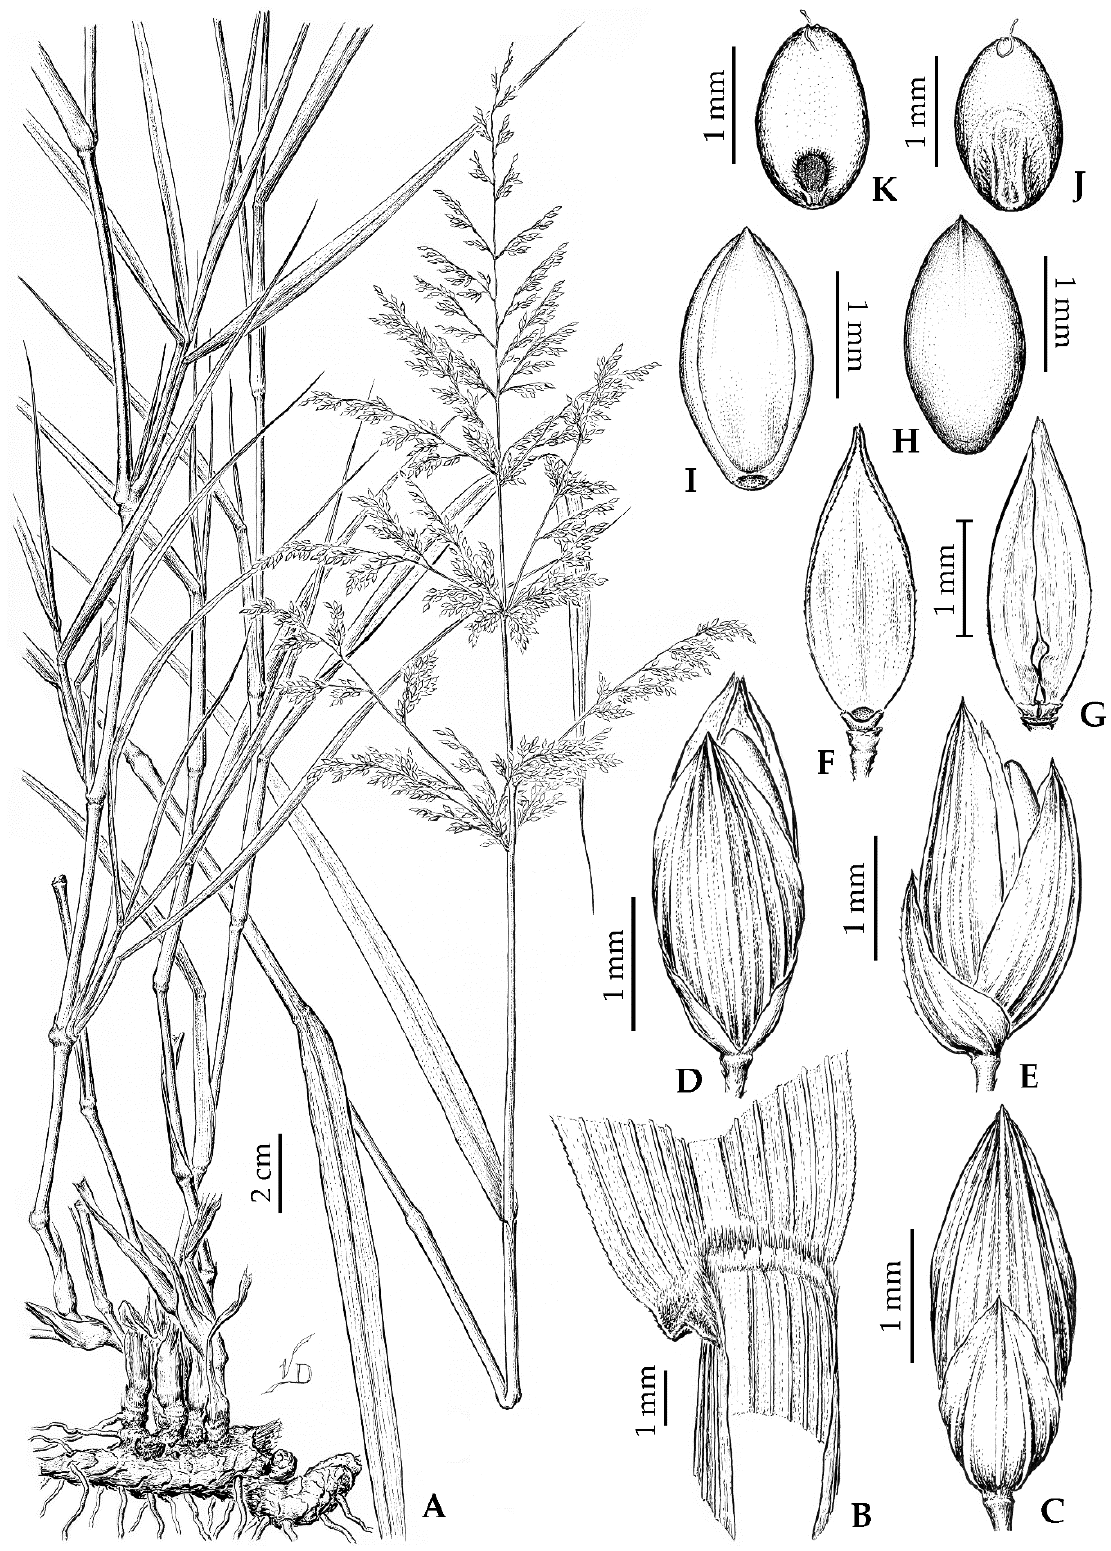
Figure 2. Janochloa antidotale (Retz.) Zuloaga & Delfini: ( A ). Plant; ( B ). Ligular region; ( C ). Spikelet, ventral view; ( D ). Spikelet, dorsal view; ( E ). Spikelet, lateral view; ( F ). Lower palea, dorsal view; ( G ). Lower palea, ventral view; ( H ). Upper anthecium, dorsal view; ( I ). Upper anthecium, ventral view; ( J ). Caryopsis, embryo view; ( K ). Caryopsis, hilum view. [( A–K ): F.O. Zuloaga et al. 7091 (SI); Drawn by Vladimiro Dudás].